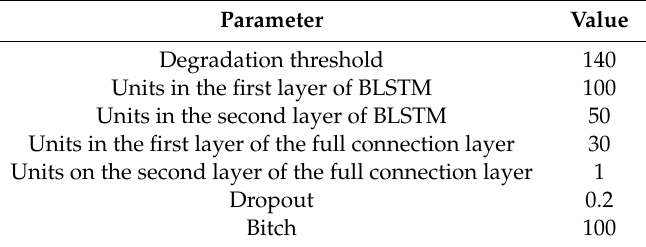
Table 5. Parameter setting of the BLSTM hybrid